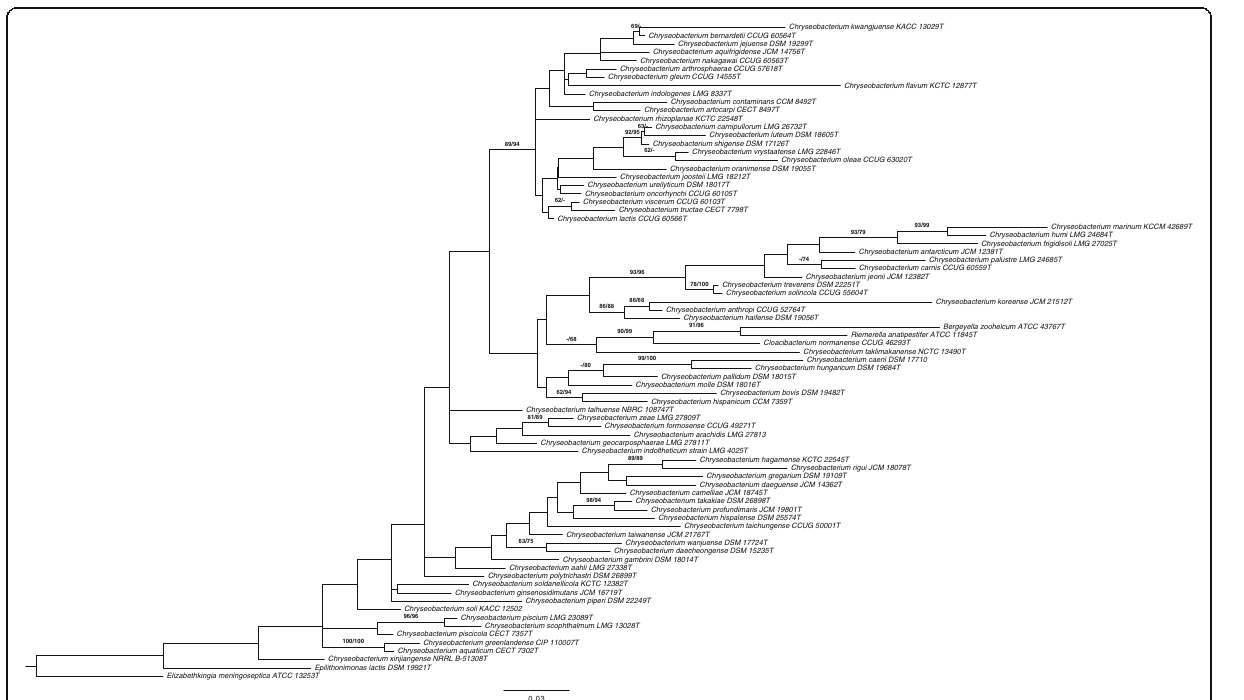
Fig. 1 Phylogenetic tree highlighting the position of Chryseobacterium bovis relative to type species within the genus Chryseobacterium . Maximum likelihood (ML) tree inferred under the GTR+CAT model and rooted with Elizabethkingia . The branches are scaled in terms of the expected number of substitutions per site. The numbers above the branches are support values when larger than 60% from ML (left) and maximum parsimony (MP, right) bootstrapping. Phylogenies were inferred by the GGDC web server [34] available at (http://ggdc.dsmz.de) using the DSMZ phylogenomics pipeline [35] adapted to single genes. A multiple sequence alignment was created with MUSCLE [36]. ML and MP trees were inferred from the alignment with RAxML [37] and TNT [38], respectively. For ML, rapid bootstrapping in conjunction with the autoMRE bootstopping criterion [39] and subsequent search for the best tree was used; for MP, 1000 bootstrapping replicates were used in conjunction with tree-bisection-and-reconnection